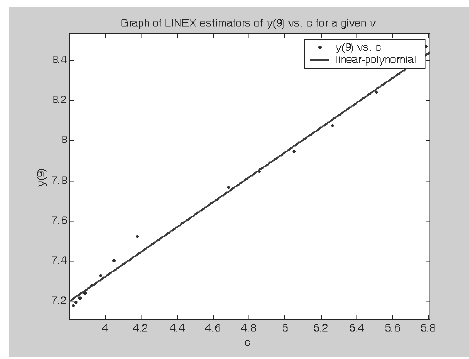
Figure 5 – Graph of LINEX estimators of (9) y vs. c for a given v .